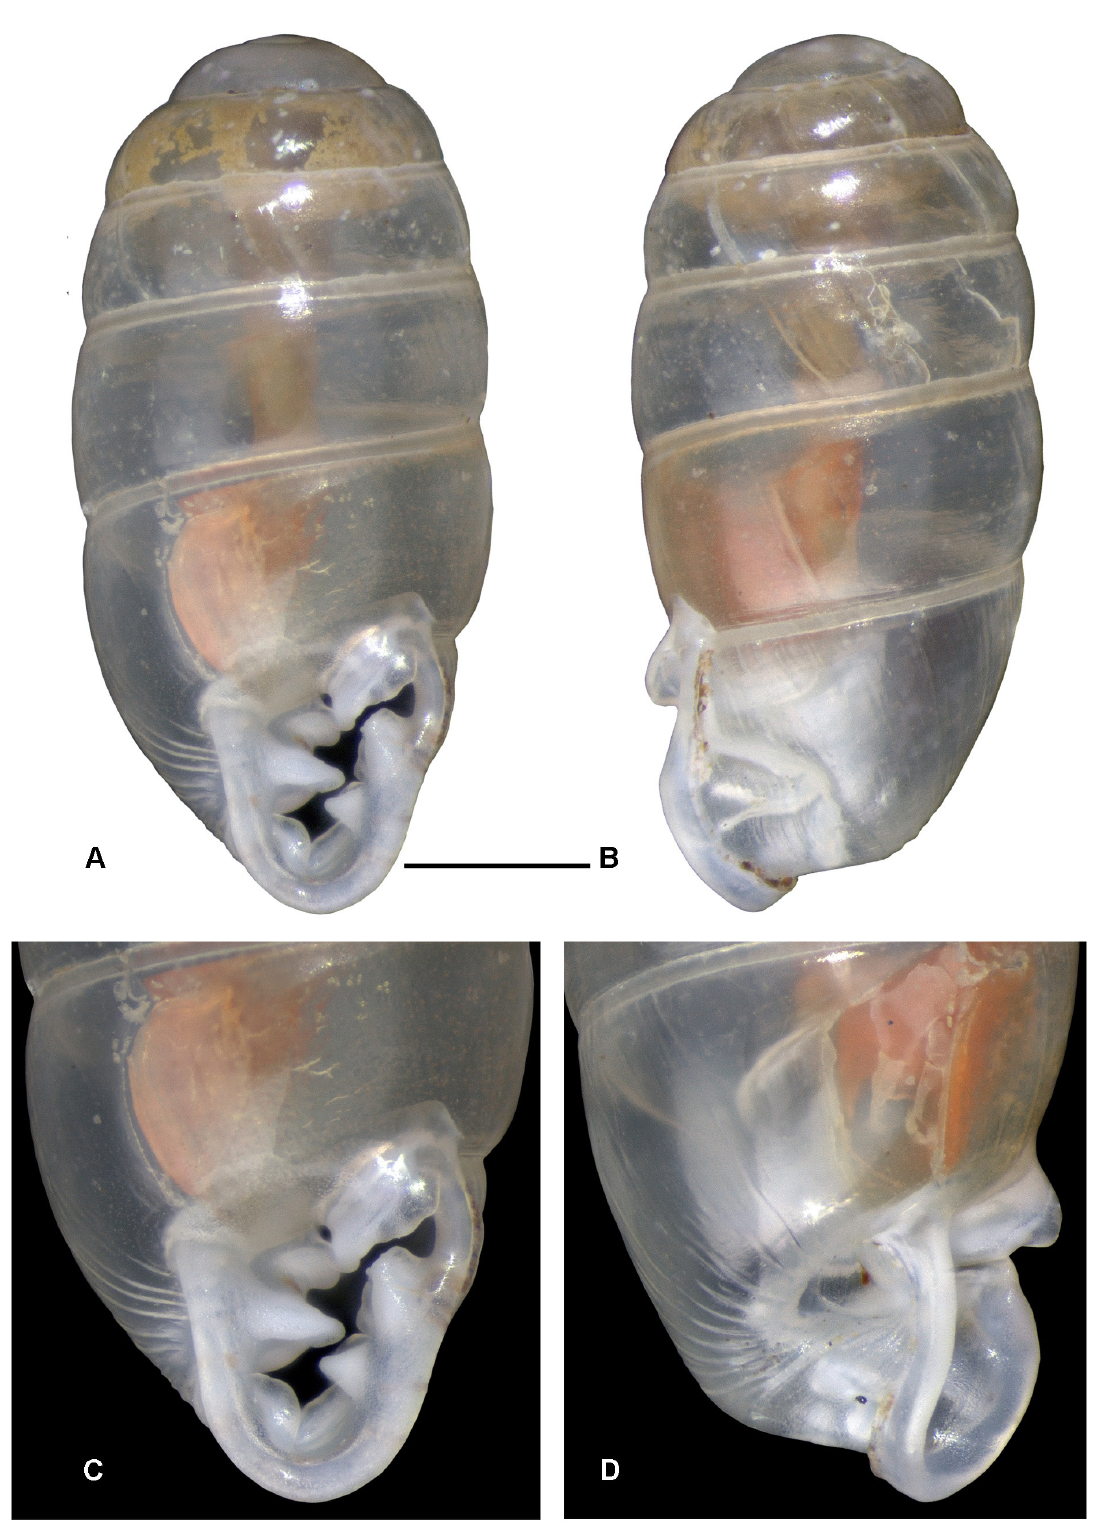
Fig. 4. Gulella mkombeni sp. nov., holotype (NMSA P1674/T4518), length 2.45 mm, width 1.14 mm. A . Aperture view. B . Side view. C . View into aperture. D . Oblique view of base showing umbilicus. Scale bar = 0.5